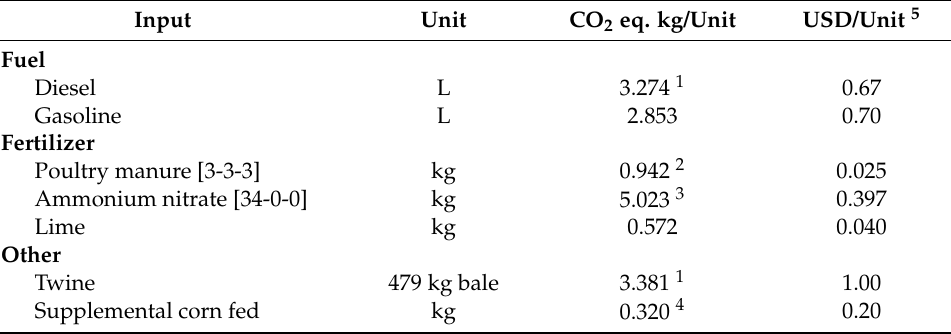
Table 1. Carbon dioxide equivalent emission factors and costs of